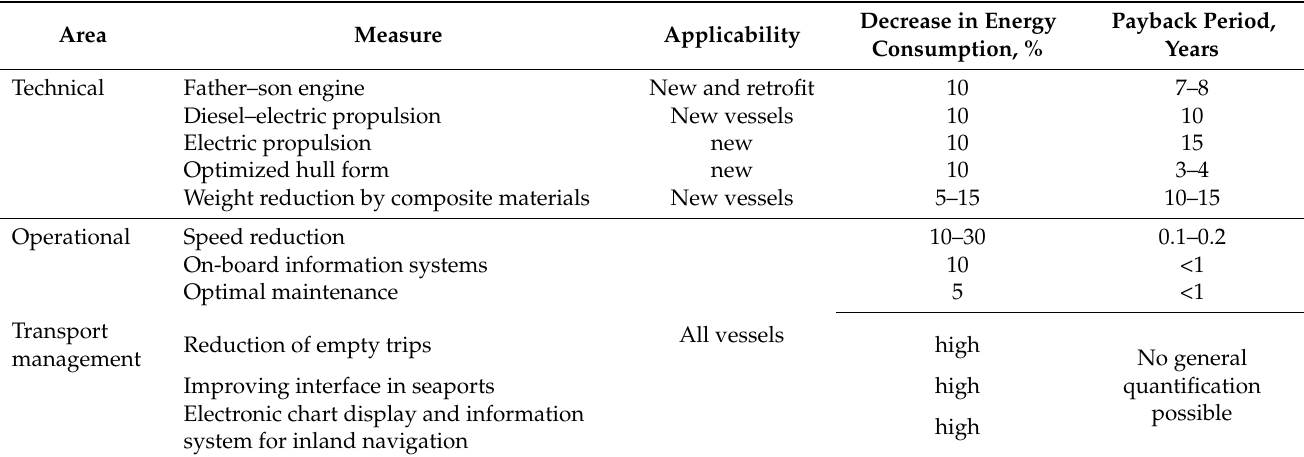
Table 5. Possible innovations to improve energy performance of